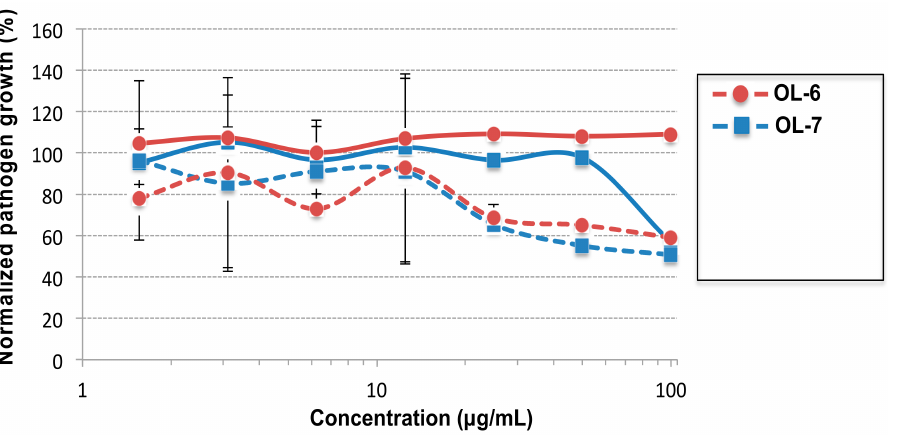
Figure 2. Antibacterial activity of the cofoldamers OL-6 and OL-7 . OL-6 (red lines) and OL-7 (blue lines) were incubated for 24 h at 37 ◦ C in 100 µ L of Mueller–Hinton broth (MHB) medium with either E. coli (continuous lines) or S. aureus (dashed lines). The control is composed of the bacterial suspension mixed with PBS (=corresponds to 100% growth). Each value corresponds to the mean value of 3 samples.